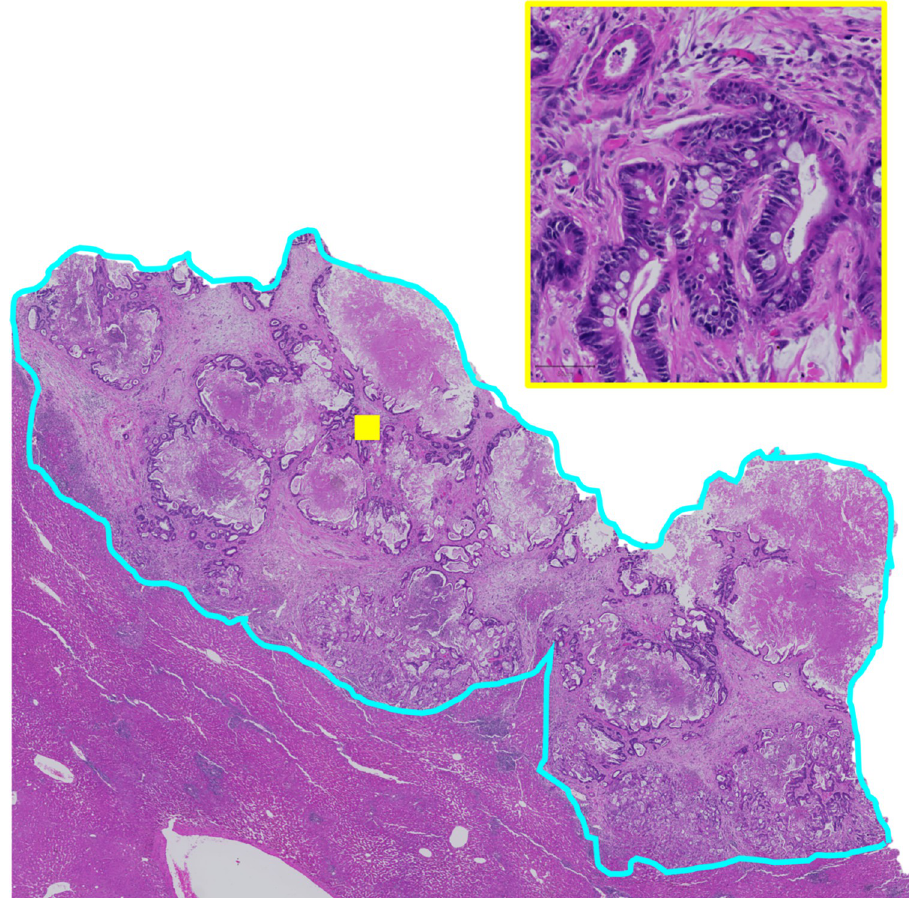
Fig 3. Representative H&E stained section of the patient CR726 FFPE CRCLM tumor sample. Tumor area is outlined with cyan and the zoomed in area within it in yellow.